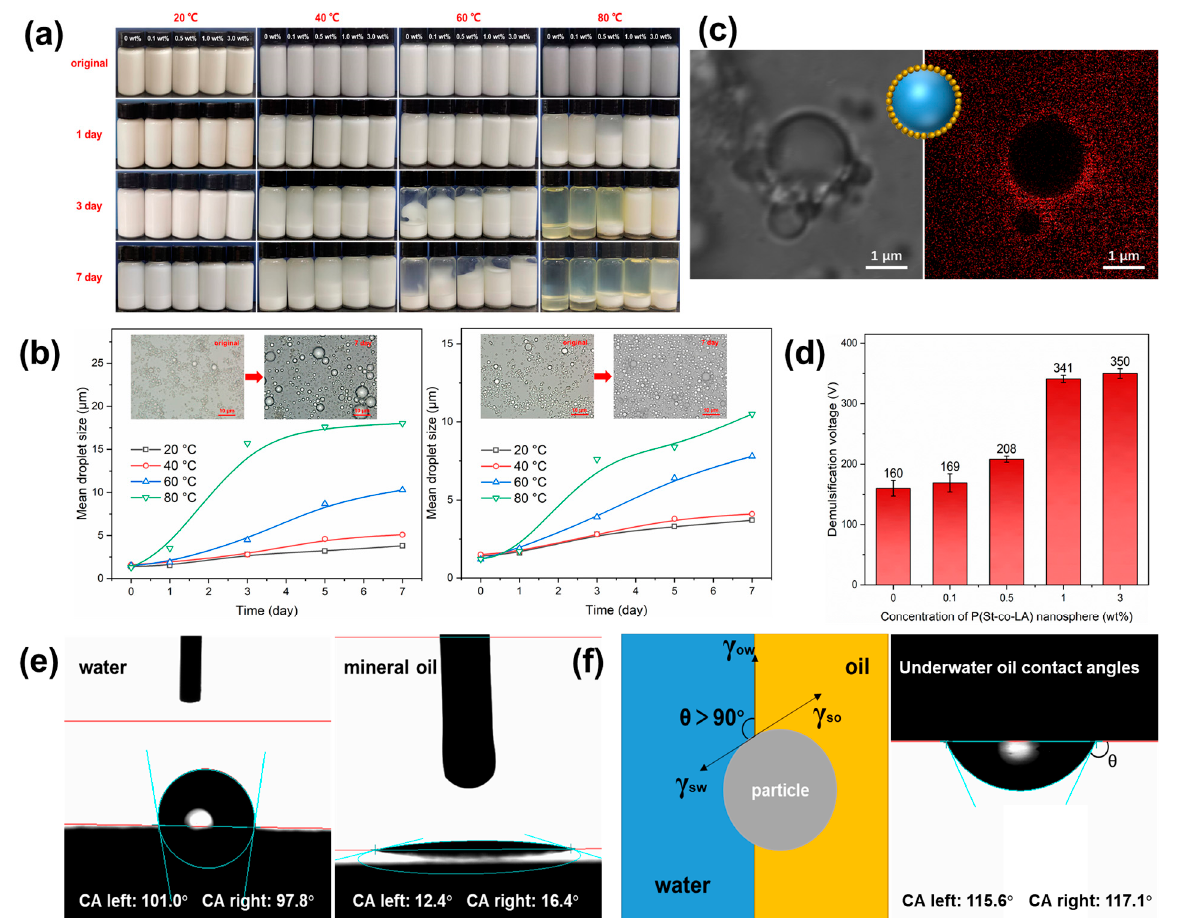
Figure 4. ( a ) Photographs of W/O emulsion with various PSL rubber nanogels concentrations (marked at the top) and ( b ) mean droplets size of W/O emulsion without PSL rubber nanogels (left) and with 3 wt% PSL rubber nanogels (right) captured on different storage days (marked at the left, up to 7 days) at different temperatures. ( c ) CLSM image of 3 wt% PSL rubber nanogels stabilized W/O emulsions. The red parts are PSL rubber nanogels stained by Nile Red. ( d ) Demulsification voltage of W/O emulsion with various PSL rubber nanogels concentrations. ( e ) Contact angle of water (left) and of mineral oil (middle) on the PSL rubber nanogels film in air and underwater oil contact angles of mineral oil (right) on the PSL rubber nanogels film. ( f ) Schematic diagram of the mechanism of PSL rubber nanogels improving the stability of emulsion.